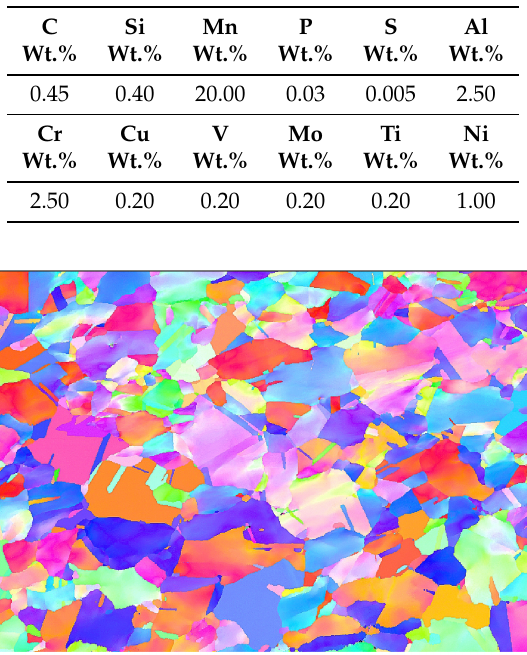
Table 1. Chemical composition of the austenitic TWIP steel X40MnCrAl19-2 (Fe: Bal).